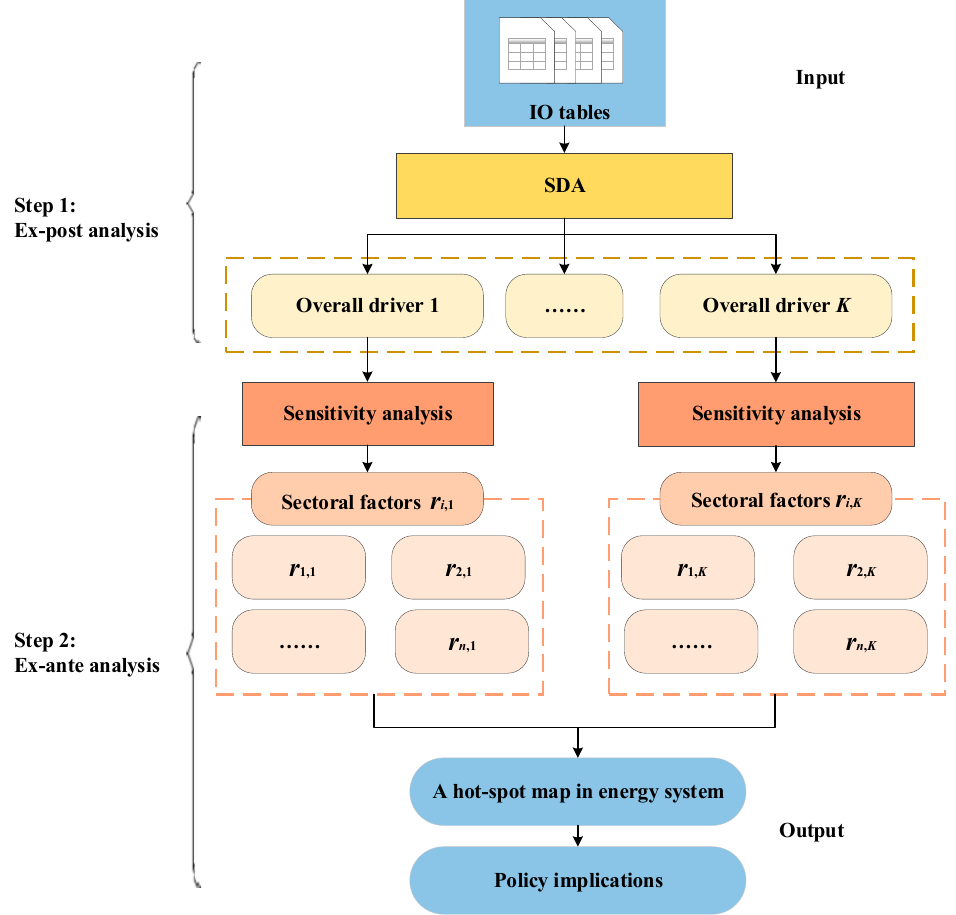
Figure 1. General framework of the proposed hybrid SDA and sensitivity analysis approach. The notation r i,j ( i = 1,…, n ; j = 1,…, K ) represents the essential factor in sector i of the j th overall driver, n is the total number of sectors, and K is the total number of the overall drivers.